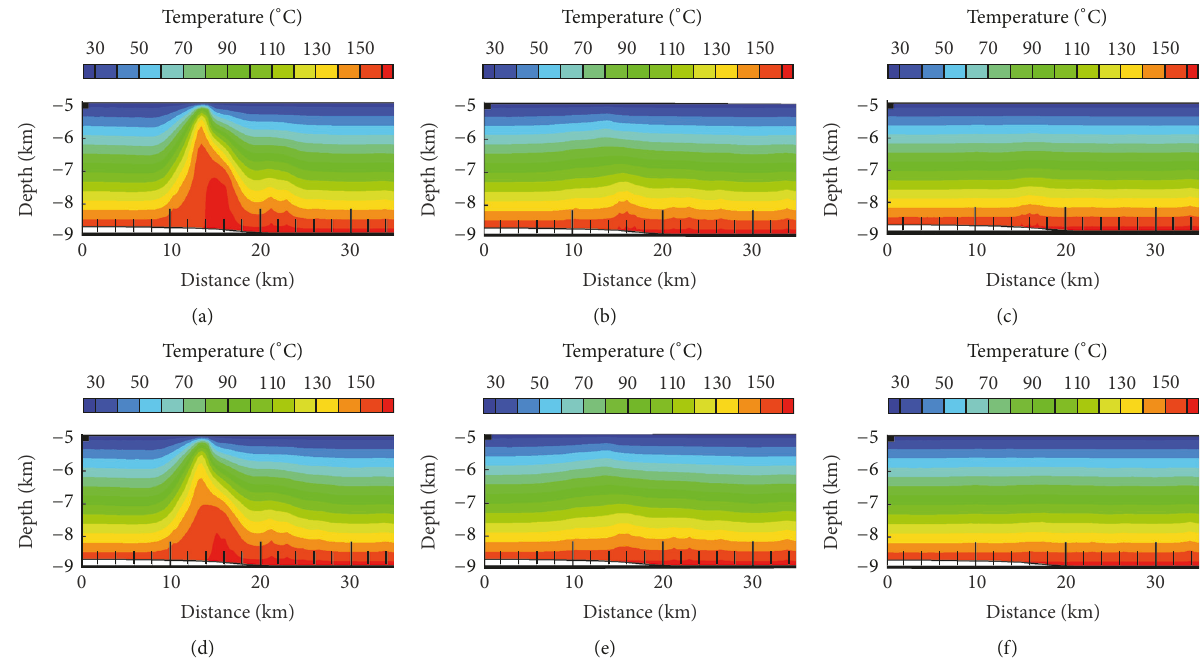
Figure 14: The temperature patterns for Scenario I with fault permeability of 1 × 10 −13 m 2 : (a) 𝑘 h : 𝑘 v = 1 , (b) 𝑘 h : 𝑘 v = 10 , and (c) 𝑘 h : 𝑘 v = 100 and fault permeability of 1 × 10 −15 m 2 : (d) 𝑘 h : 𝑘 v = 1 , (e) 𝑘 h : 𝑘 v = 10 , and (f) 𝑘 h : 𝑘 v = 100